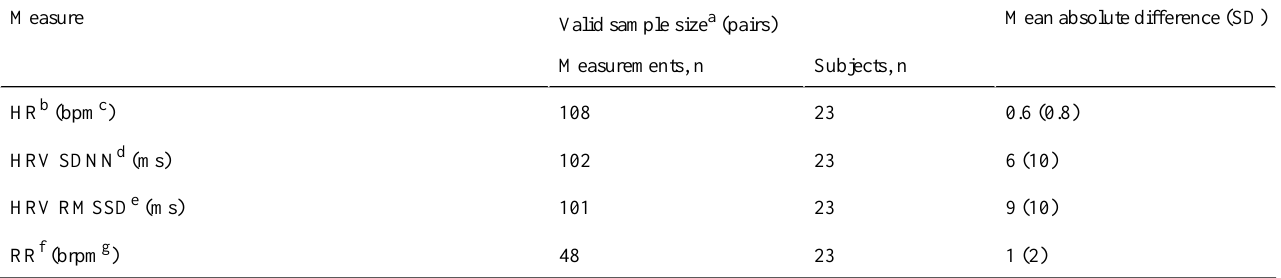
Mean absolute difference (SD)Valid sample size a (pairs)Measure